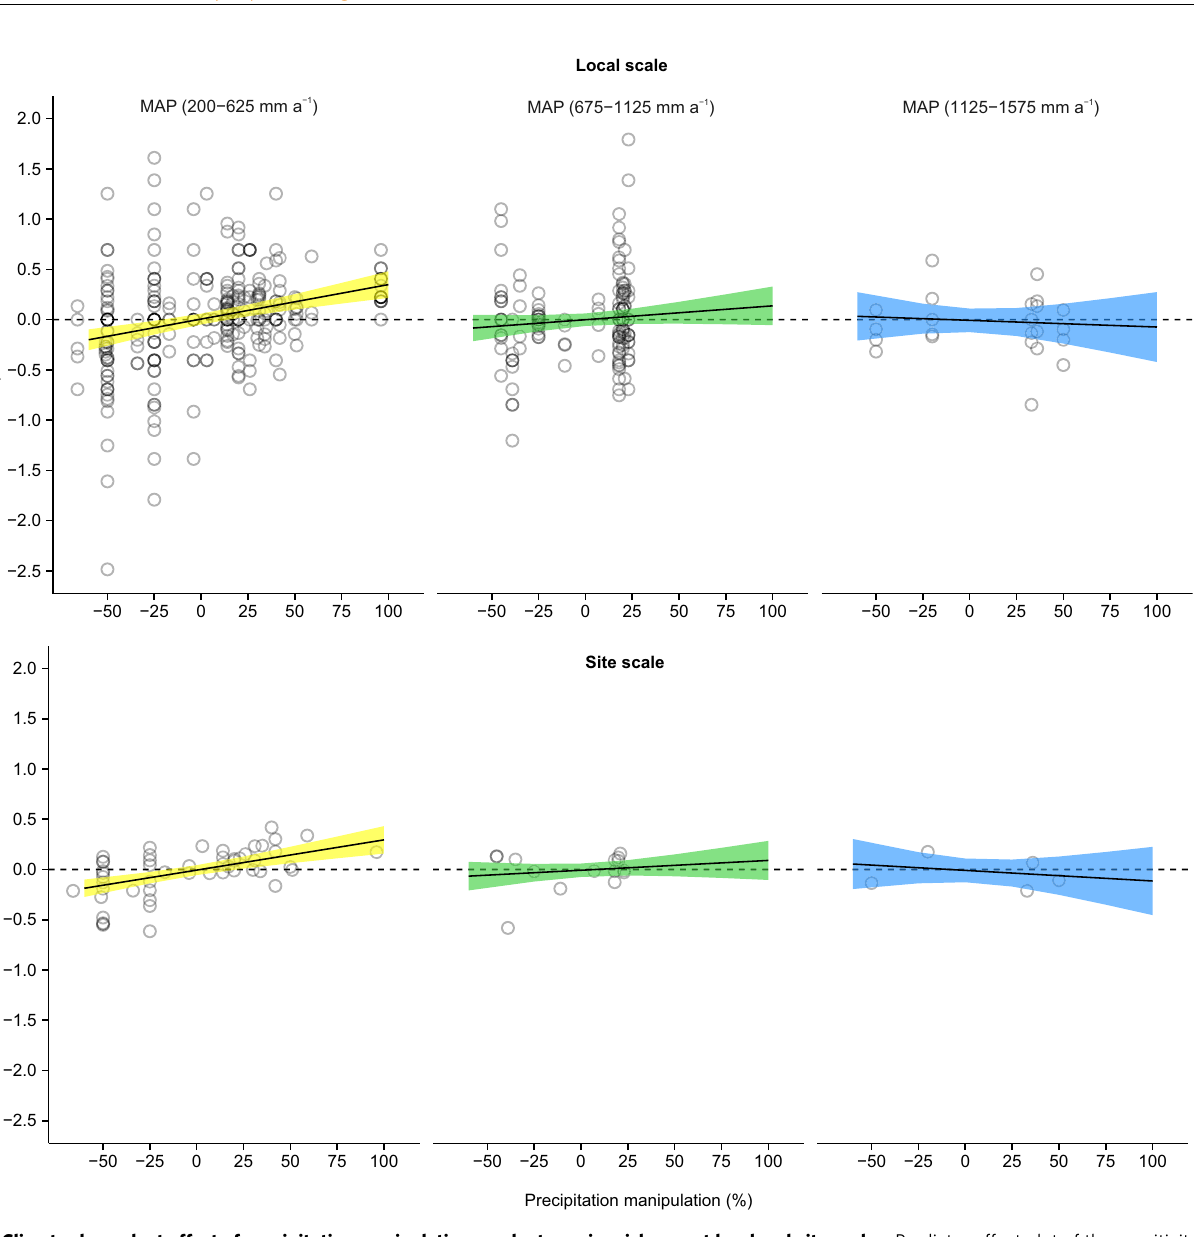
Fig. 3 Climate-dependent effect of precipitation manipulation on plant species richness at local and site scales. Predictor effect plot of the sensitivity of the log response ratio of species richness at the local scale ( a ) and site scale ( b ) to manipulations in the magnitude of precipitation manipulation (%) depending on the range of background mean annual precipitation (MAP). Parameter estimates (mean and 95% con fi dence intervals) to create this fi gure are obtained from the simplest model including the interaction between magnitude of precipitation manipulation and MAP (Supplementary Tables 2 and 3). Different colors represent different ranges in background MAP: yellow, 200 – 675 mm a − 1 ( n = 300 at the local scale and n = 52 at the site scale); green, 675 – 1125 mm a − 1 ( n = 139 at the local scale and n = 15 at the site scale); blue, 1125 – 1575 mm a − 1 ( n = 23 at the local scale and n = 5 at the site scale). Data points represent the log response ratios of original